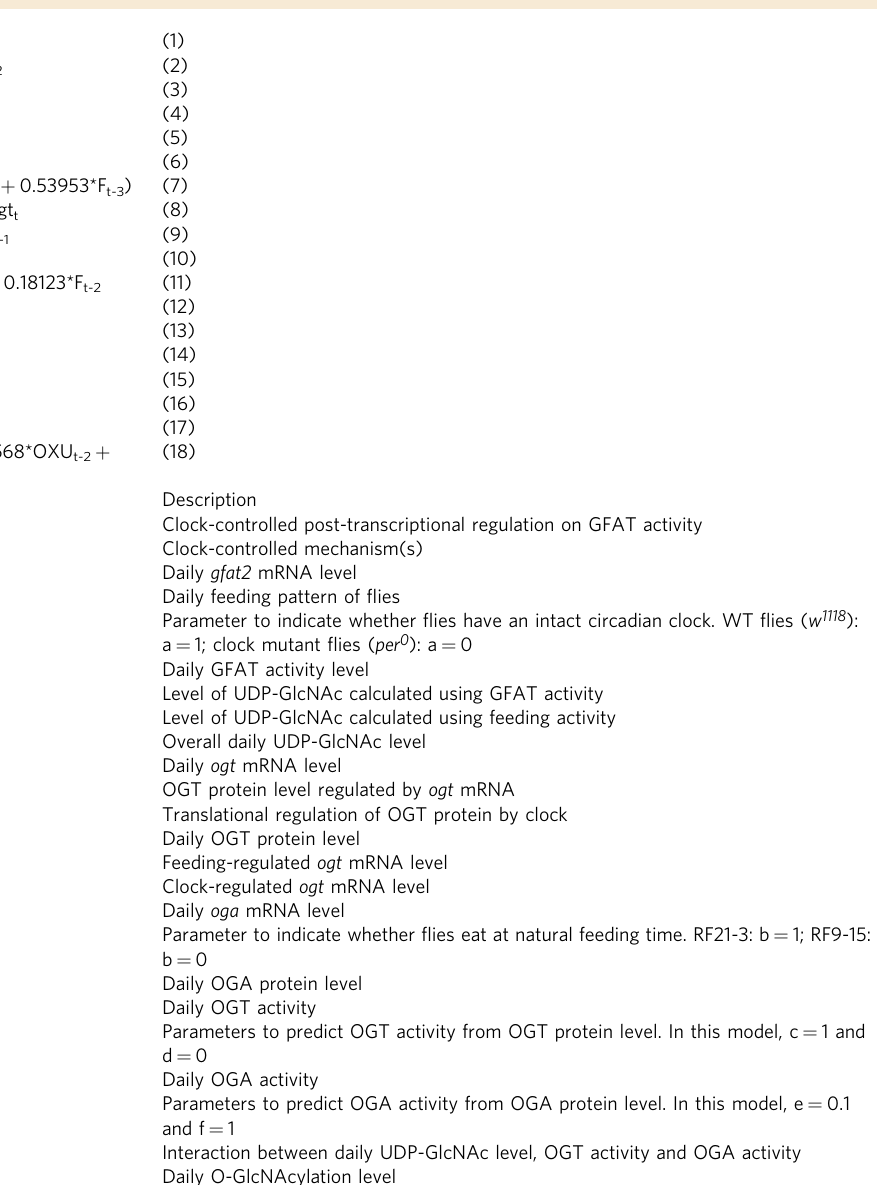
Table 1 Mathematical model describing key parameters that regulate daily rhythms of protein